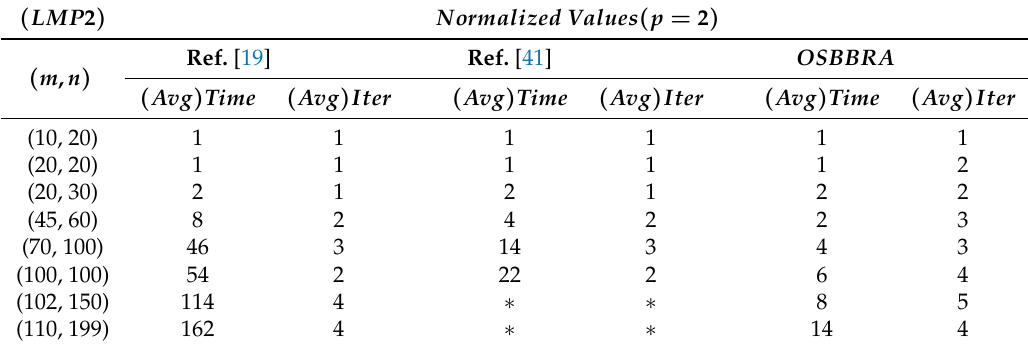
Table 7. Computational results of Normalized values on